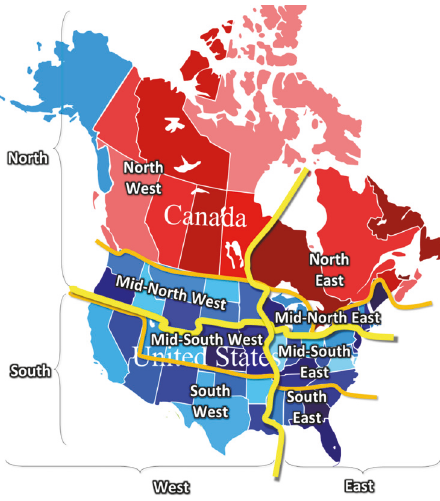
Figure 4: Geographic coarse-graining of bird populations among 59 states in Northern America